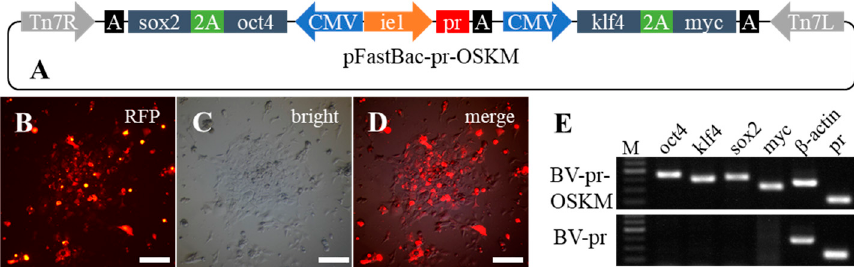
Figure 4. Expressions of exogenous oct4, sox2, klf4 , and myc in BV-pr-OSKM-transduced ZF4 cells. ( A ) Structure of pFastBac-pr-OSKM. Driven by a CMV promoter, oct4 and sox2 were fused by a 2A peptide, which was similar in klf4 and myc . ( B – D ) ZF4 cells transduced with BV-pr-OSKM. Scale bars, 200 μ m. ( E ) cDNA fragments of oct4 (400 bp), klf4 (399 bp), sox2 (385 bp), myc (312 bp), β - actin (382 bp), and pr (221 bp) were detected by semiquantitative RT-PCR in ZF4 cells transduced with BV-pr-OSKM or control BV-CMV-ie1-pr (BV-pr). M, DNA marker; oct4, octamer-binding transcription factor 4; sox2, sex determining region Y-box 2; klf4, Kruppel-like factor 4; myc, homology with the Avian viral gene v-myc.